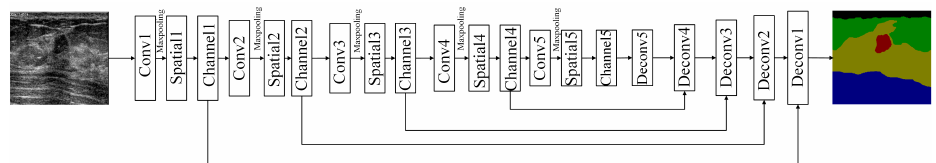
Figure 2. The proposed network structure.